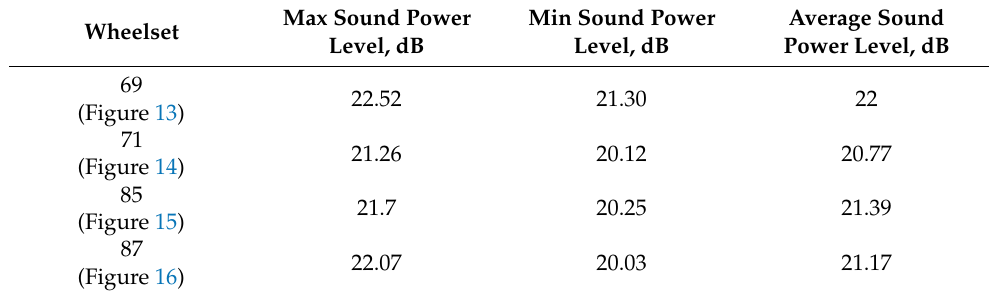
Table 10. Results of sound power level calculation.